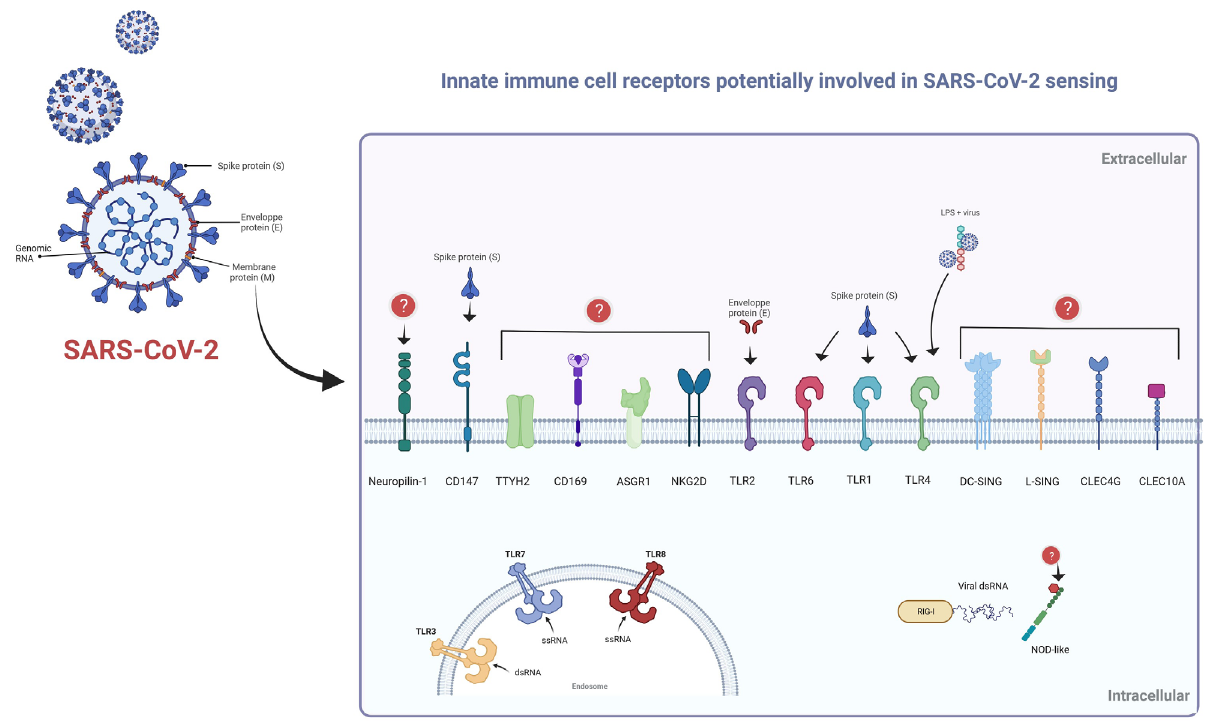
Figure 2. Cellular receptors of innate immunity are potentially involved in SARS-CoV-2 sensing. Schematic representation of cell receptors involved in SARS-CoV-2 detection. Surface-exposed receptors: TLR1, TLR6, and TLR4 can interact with the S protein; whereas TLR2 can bind to the E protein. Circulating LPS can bind to S protein, so the virus can indirectly bind to TLR4. S protein can also physically bind to CD147; however, the putative ligands of certain receptors remain unknown. Endosomal TLR3, TLR7, and TLR8 are involved in viral RNA recognition. Moreover, cytosolic RNA can be recognized by RIG-I-type receptors; however, the mechanism of NOD-like detection has not been fully elucidated. TTYH2: tweety family member 2; ASGR1: asialoglycoprotein receptor 1; DC-SING: DC-specific intercellular adhesion molecule-3-grabbing non-integrin; L-SING: liver/lymph node-specific intercellular adhesion molecule-3-grabbing integrin; CLEC4G: C-type lectin domain family 4, member G; ssRNA: single-stranded RNA; dsRNA: double-stranded RNA. This Figure was created with BioRender software (https://biorender.com/) using pre-generated